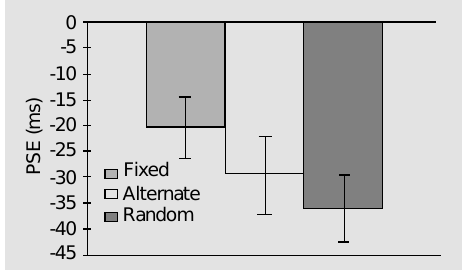
Figure 2. Point of subjective equality (PSE) obtained in all three situations. The PSE values are reported in milliseconds (by dividing the misalignment angles by the angular velocity of the rotating dots) ± SEM. Nega- tive values for the PSE mean that the rotating dots had to be lagging behind the flashing dot in order to be perceived as aligned with them, i.e., the ro- tating dots were perceived as leading the flashing dot when they happened to be in perfect alignment with each other. The opposite holds for positive PSE